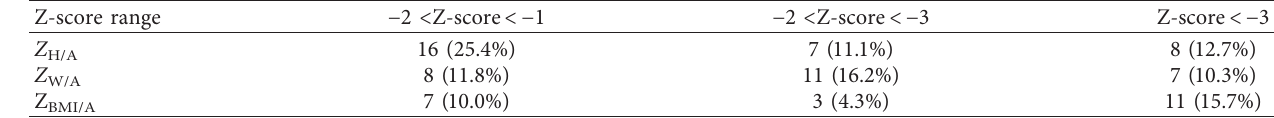
Table 1: The mean Z H/A , Z W/A , and Z BMI/A in patients.